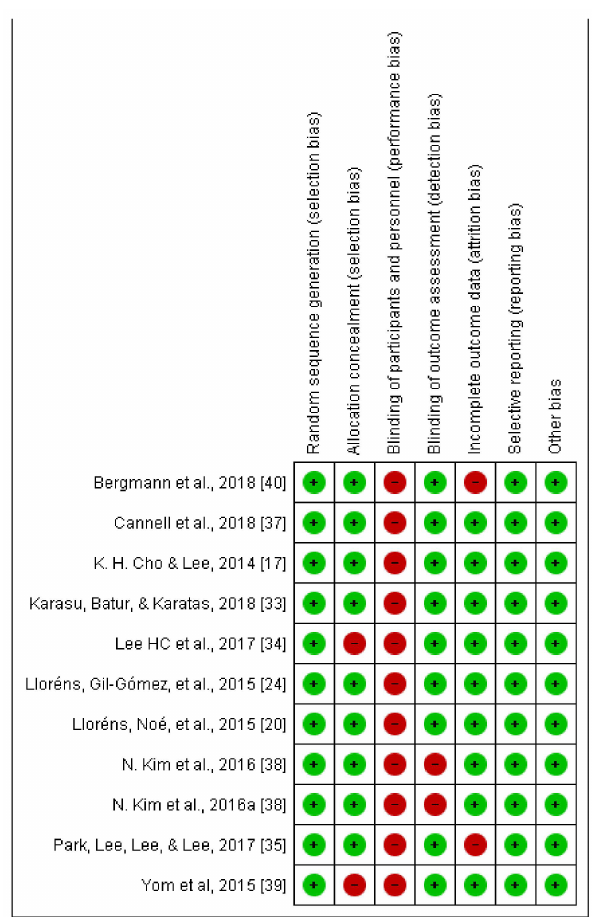
Figure 2. The Cochrane